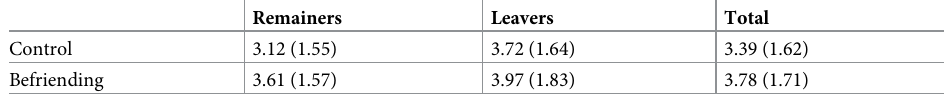
Table 2. Perceived commonality scores: Descriptive statistics.